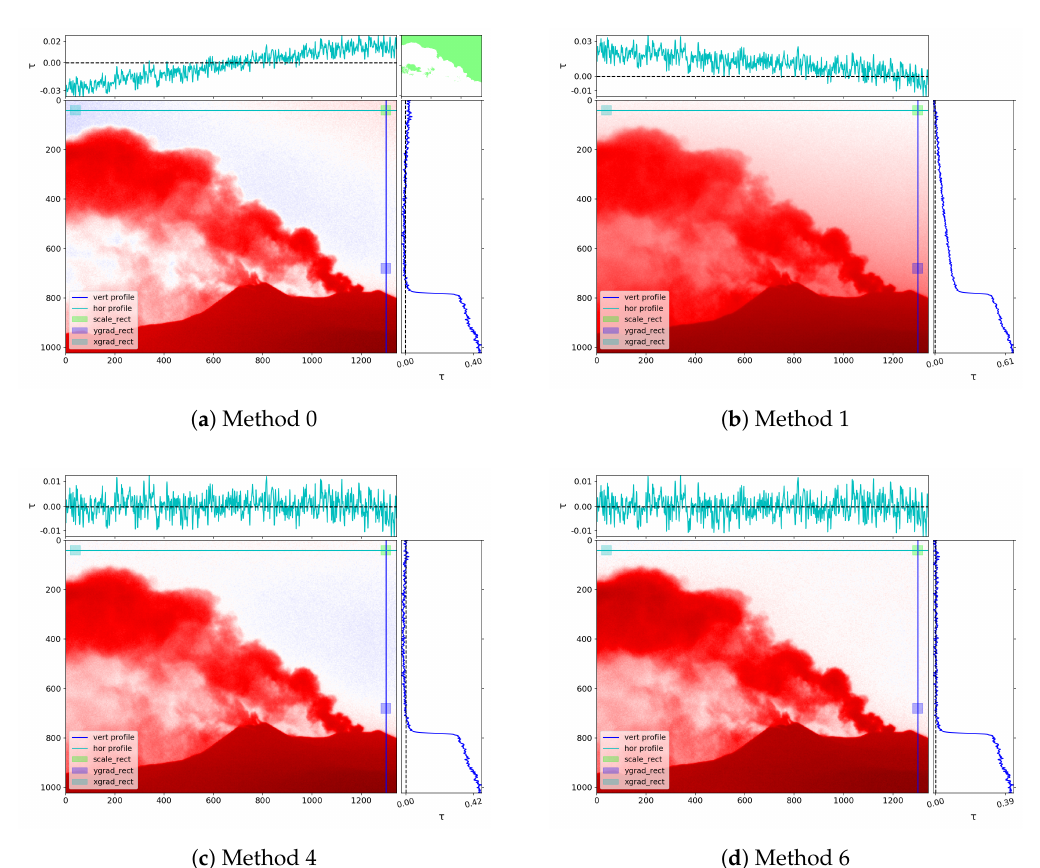
Figure 4. Plume background modelling. Four examples of on-band OD images ( τ on ) determined using background modelling methods 0 (polynomial surface fit) and 1, 4 and 6 (based on I 0 -image, cf. Table 2). Horizontal and vertical profiles are plotted on the top and on the right, respectively. The top-left plot (Method 0) further includes the mask specifying sky-reference pixels (green area) that was used for the polynomial surface fit. The plume and background images used for the displayed examples were recorded at 7:06 a.m. UTC and at 7:02 a.m. UTC,